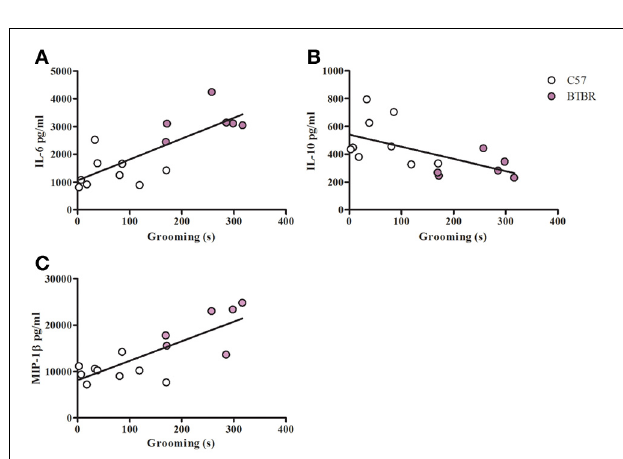
FIGURE 3 | Grooming correlation in unstimulated macrophages. Scatter graphs and linear regression of IL-12(p40) (A) and IP-10 (B) in unstimulated macrophages. Correlation coefficients ( r -value) and p- values were calculated with Spearman’s correlation analysis. (A) C57 r -value: 0.27, p- value: 0.493; BTBR r -value: 0.88, p- value: 0.033 ∗ ; Across strains r -value; 0.58, p- value: 0.024 ∗ (B) C57 r -value: 0.23, p- value: 0.546; BTBR r -value: 0.43, p- value: 0.397; Across strains r -value: 0.55, p- value: 0.032 ∗ ; ∗ significant p- values.